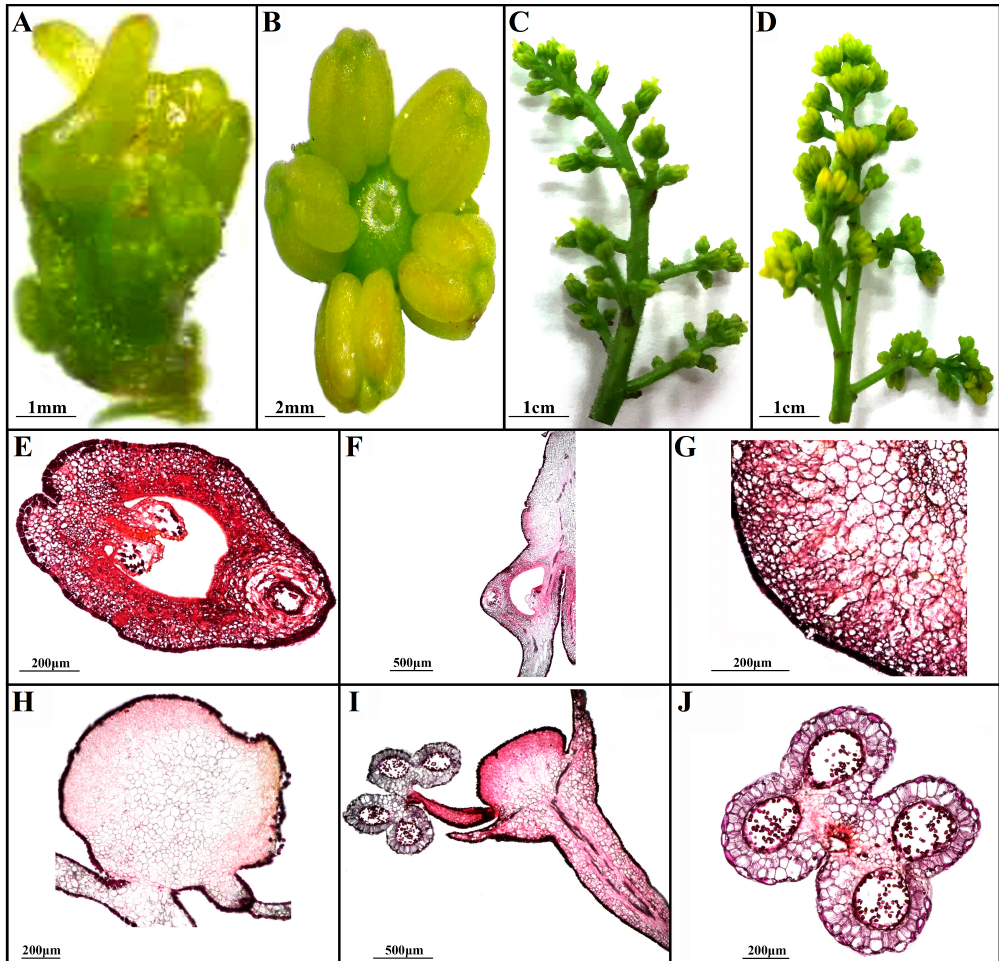
Figure 1. Morphology of female and male flowers of Z. armatum . ( A , C ) Female flower; ( B , D ) male flower; ( E ) female flower crosscutting structure; ( F ) female flower longitudinal cutting structure; ( G ) female flower periphorium structure; ( H ) male flower crosscutting structure; ( I ) male flower longitudinal cutting structure; ( J ) anther crosscutting structure.